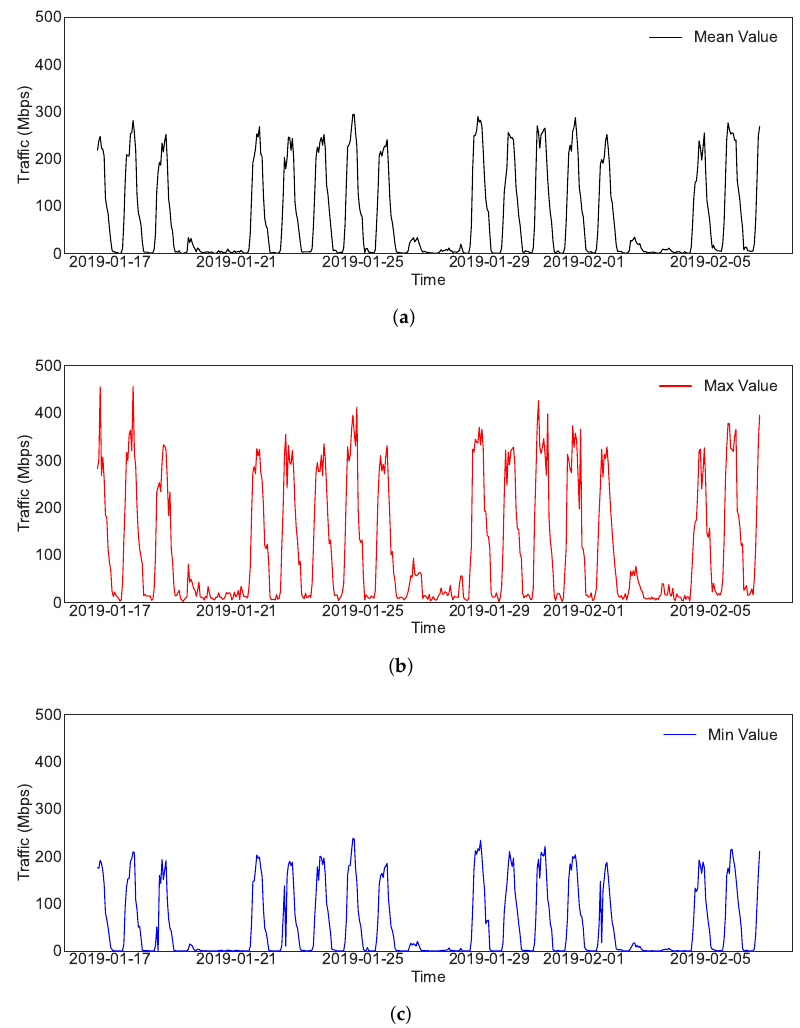
Figure 1. The Internet traffic data in the first three weeks. ( a ) Mean values; ( b ) Maximum values; ( c ) Minimum